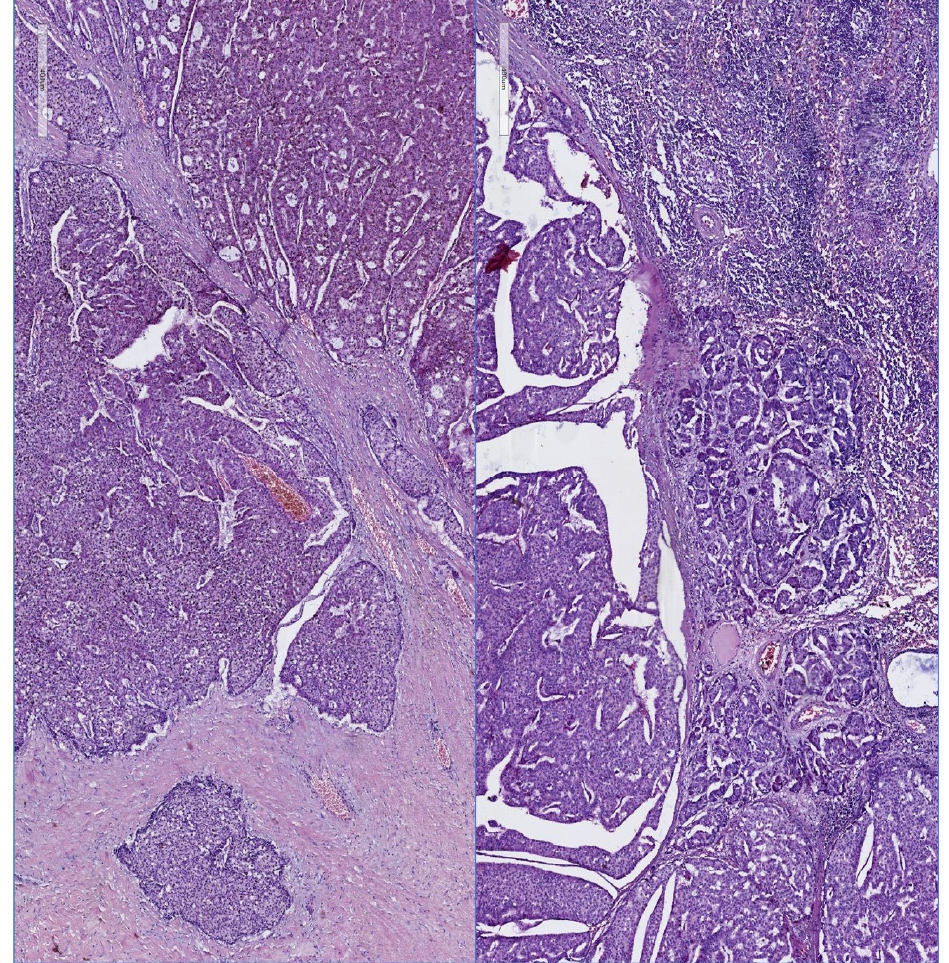
Figure 3. Surgical resected specimen, same case: left panel: invasive mammary carcinoma, right panel: tumor invasion in an axillary lymph node, HE, 100 × . Figures 2 and 3 are presented courtesy